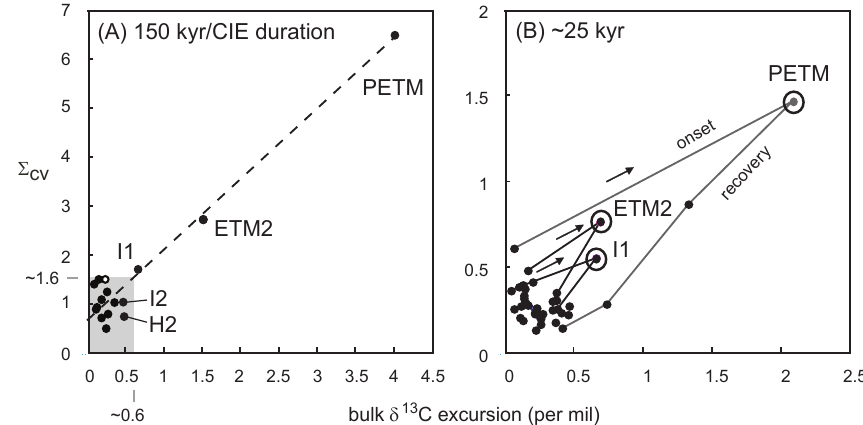
Fig. 4. Scatter plots of summed coefficients of variation ( 6 cv ) against magnitude of carbon isotope excursion. Panel (A) shows the 6 cv values from Fig. 2c plotted for each peak (using the values highlighted by red circles for H2, I1 and I2) and every intervening 150kyr. The positions of the 6 cv data points for the PETM and ETM2 are shown against inferred maximum bulk carbonate δ 13 C values (Lourens et al., 2005; Zachos et al., 2005). The level of a suspected unconformity, at ∼ 700kyr above the PETM onset, is plotted as an open black circle and the grey area represents a “background” field. Panel (B) shows the 6 cv values across 25kyr with values plotted for the peak excursions (open black circles) and every intervening 50kyr. Only data that are spaced at least as widely apart as the CV window are plotted in order for each data point to be independent of its neighbours. Stratigraphically adjacent data points are joined by lines with the arrows indicating the up-section